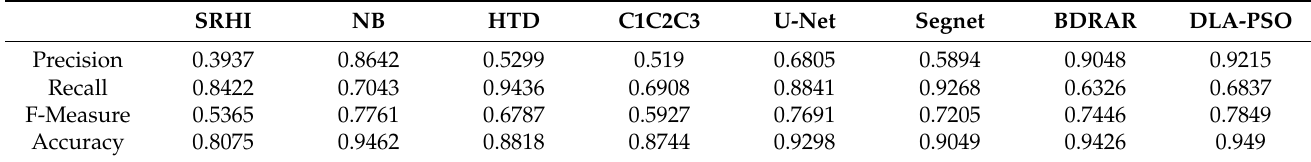
Table 5. Chicago shadow-test-evaluation index.